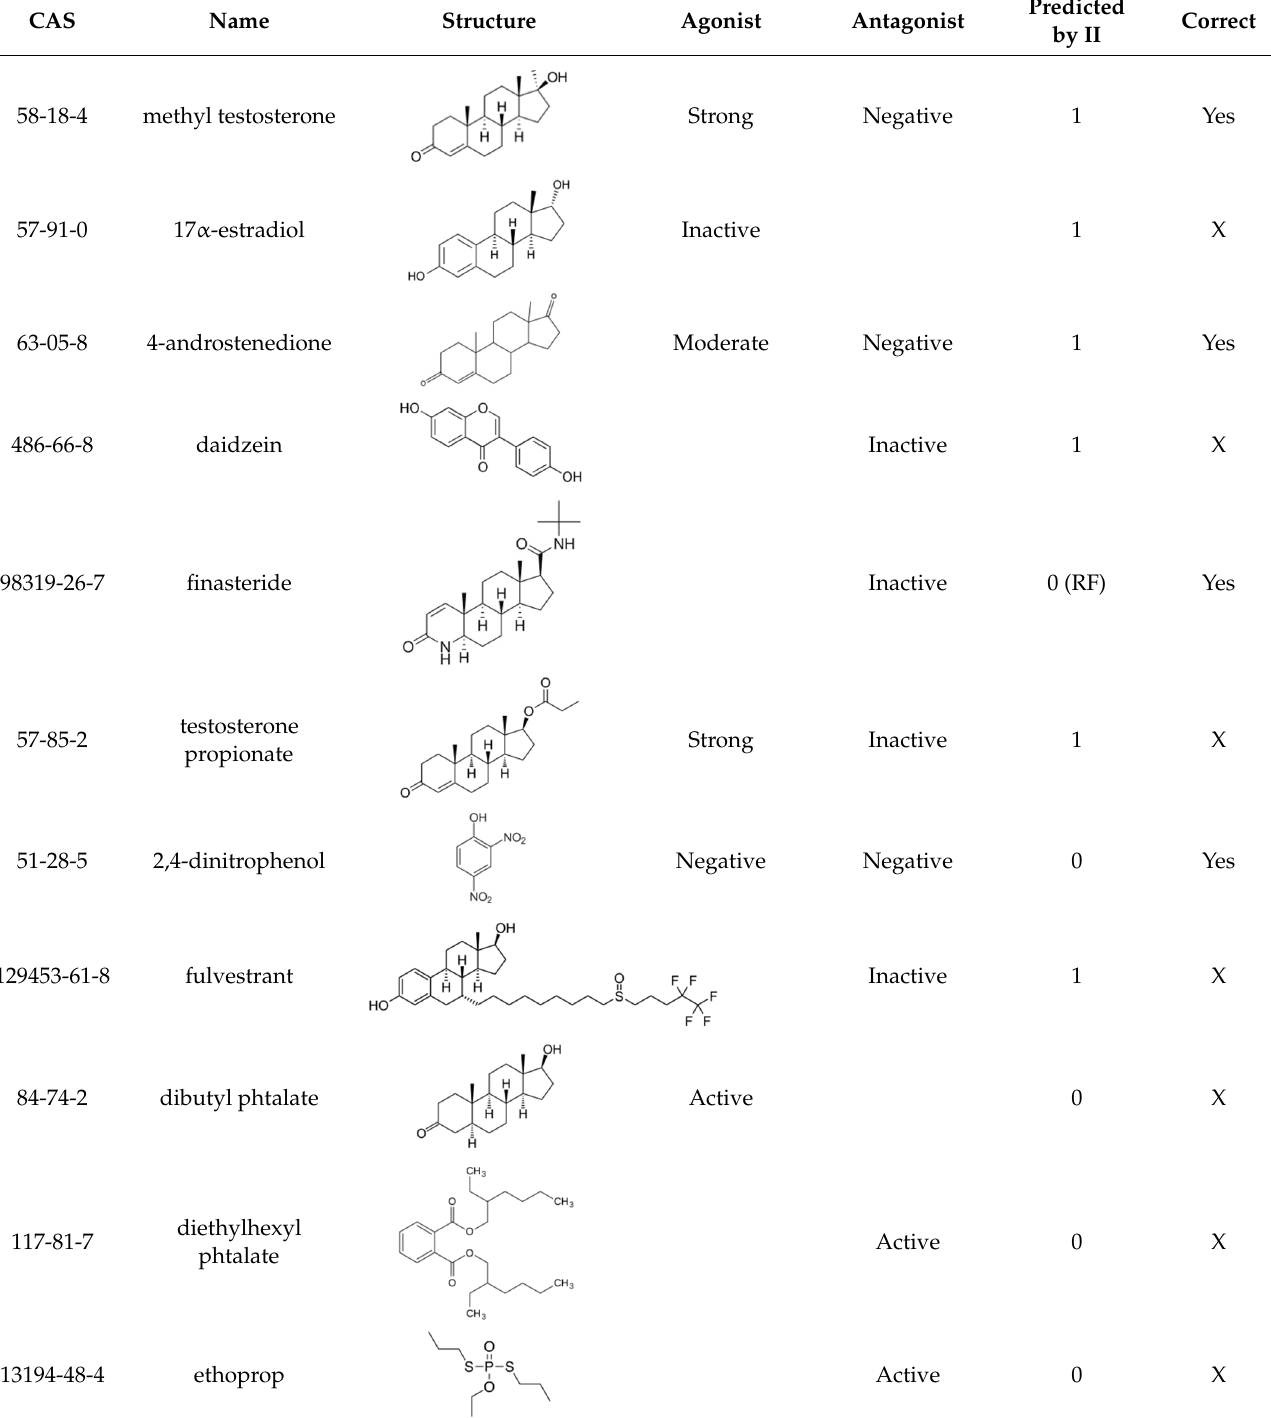
Table 3. Chemicals That Were Frequently Predicted Inaccurately by Other Machine-Learning Models [20] .